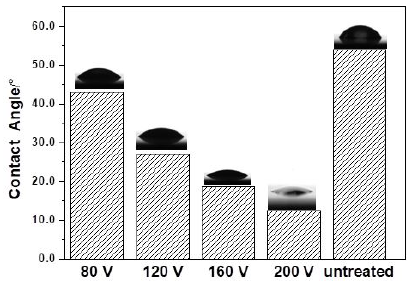
Figure 8. Thickness of the MAO films as a function of applied voltage.